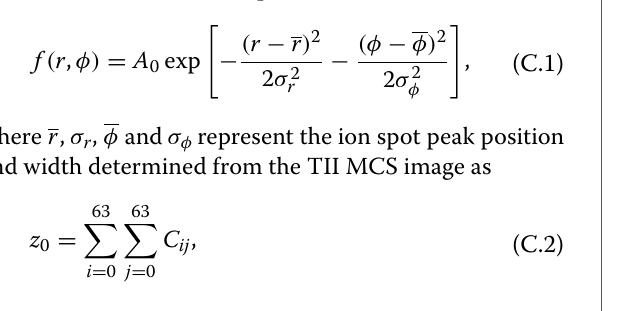
Fig. 22 Fit residuals of r . The standard deviation of 0.044